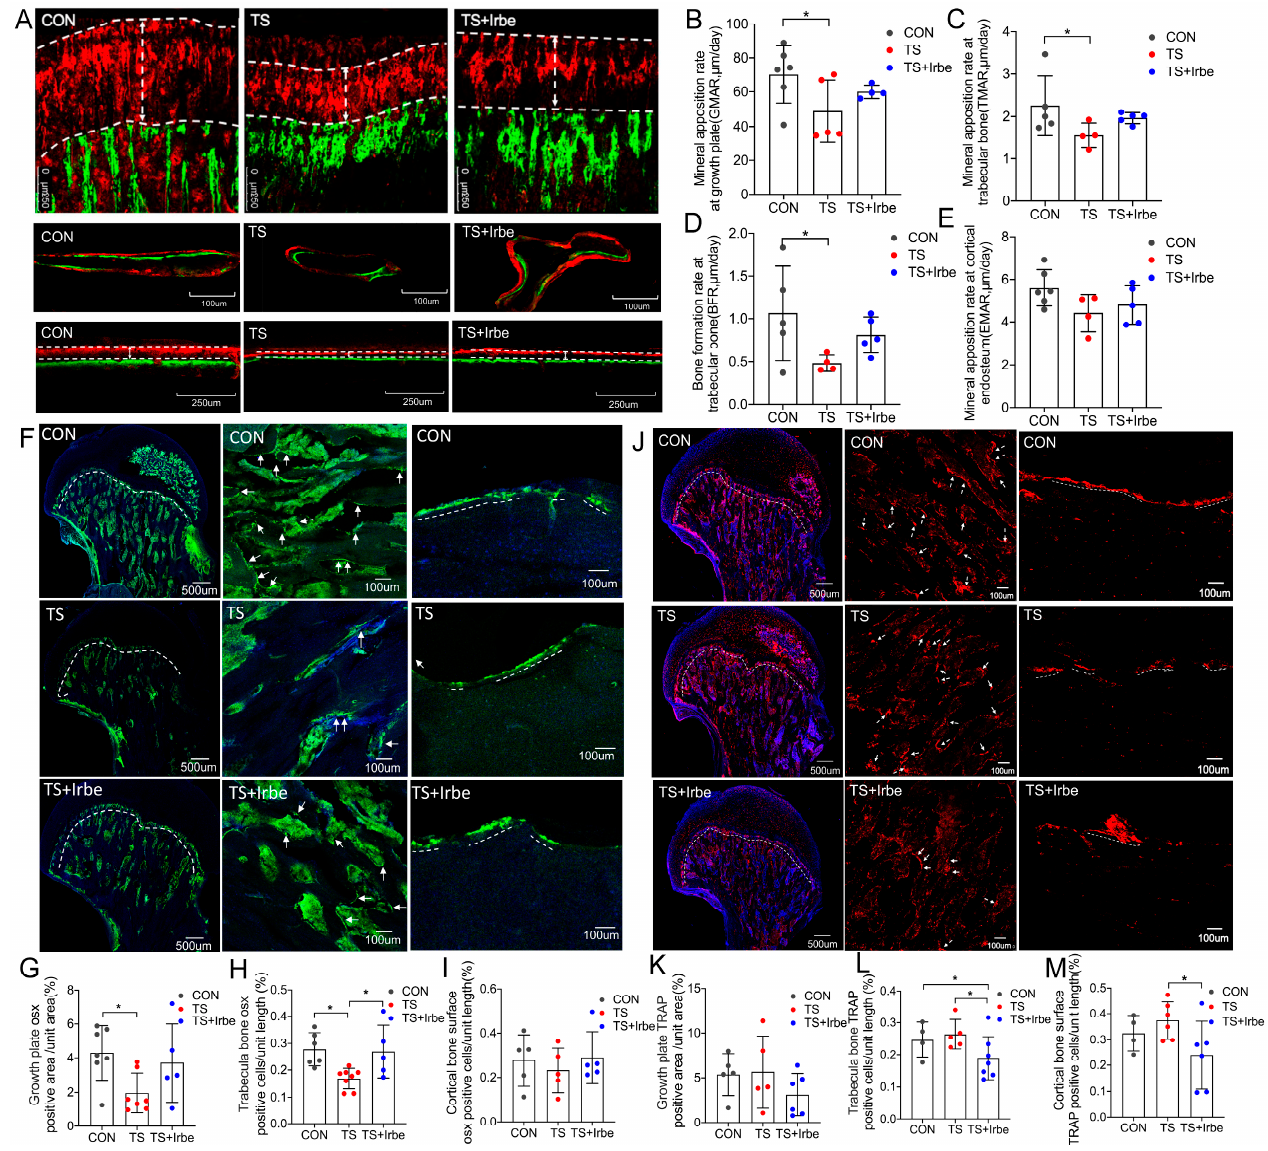
Figure 5. Inhibition of AGEs partially improved bone metabolism after tail suspension. ( A ) Rep- resentative images of calcein and xylenol orange double labeling at growth plate, trabecular bone, and cortical bone. Scale bar: 250 µ m/100 µ m. The green line was the calcein deposited in the newly formed bone, and the red line was the xylenol deposited in the newly formed bone. ( B ) Mineral apposition rate at growth plate (GMAR, µ m/day). ( C ) Mineral apposition rate at trabecular bone (TMAR, µ m/day). ( D ) Bone formation rate at trabecular bone (BFR, µ m/I). ( E ) Mineral apposition rate at cortical endosteum (EMAR, µ m/day). ( F ) Representative images of Osterix immunofluo- rescence staining in growth plate, trabecular bone, and cortical bone. White arrows and dashed lines indicate the location of positive cells (green), Nuclei was stained with DAPI (blue). Scale bar: 500 µ m/100 µ m. ( G ) Osterix positive area per unit area in growth plate (%). ( H ) Osterix (+) cells per unit length in trabecular bone (%). ( I ) Osterix (+) cells per unit length in cortical bone surface (%). ( J ) Representative images of TRAP immunofluorescence staining in growth plate, trabecular bone, and cortical bone. White arrows and dashed lines indicate the location of x cells (red), Nuclei was stained with DAPI (blue). Scale bar: 500 µ m/100 µ m. ( K ) TRAP positive area per unit area in growth plate (%). ( L ) TRAP (+) cells per unit length in trabecular bone (%). ( M ) TRAP (+) cells per unit length in cortical bone surface (%). Values are all expressed as mean ± SD. * p <